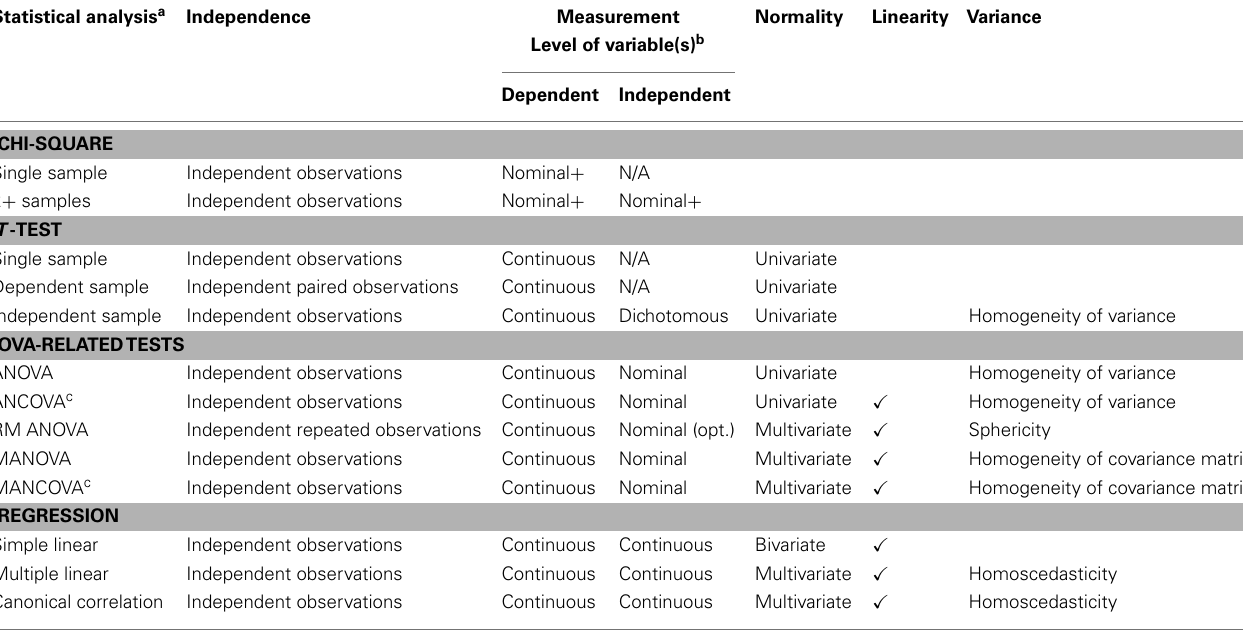
Table 1 | Statistical assumptions associated with substantive analyses across the general linear model.